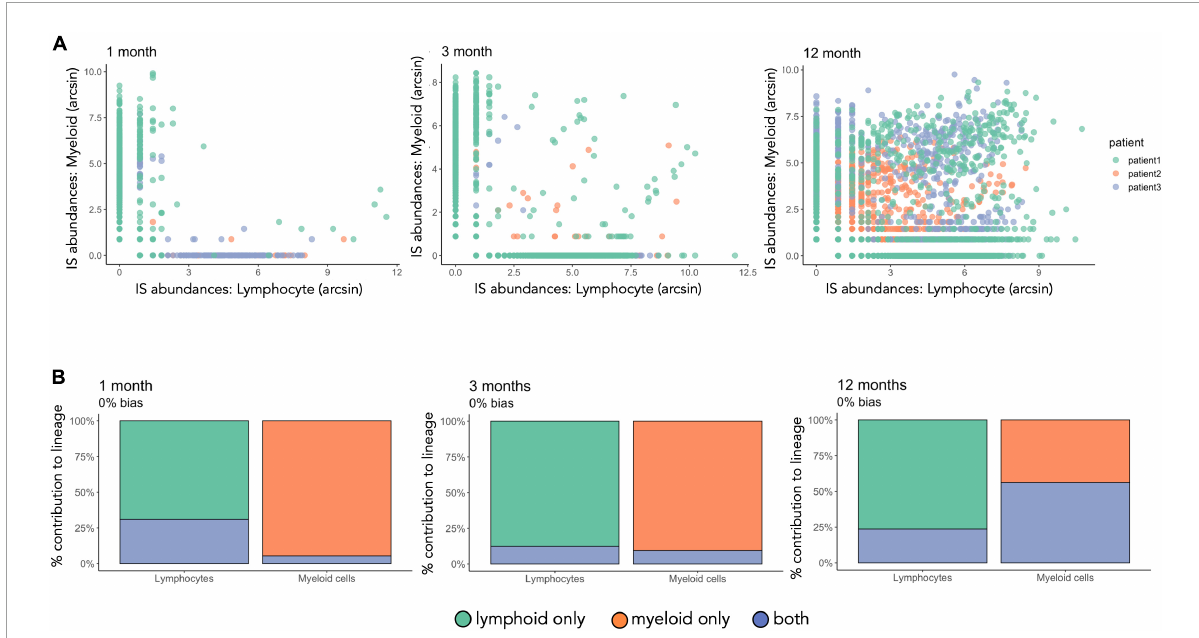
FIGURE8 Increased proportion of bi-outcome HSPC from 1 to 12 months after gene therapy. (A) IS abundances in lymphocytes versus myeloid cells for each timepoint. Each dot is an IS color-coded by patient. The number of sequencing reads per IS has been renormalized and arcsin transformed. (B) IS have been classified by presence or absence in the myeloid and lymphoid cell lineages. The total output of uni-outcome or bi-outcome HSPCs to myeloid cells and lymphocytes is computed per patient. Here we show the mean value over the three patients. Green and orange correspond to IS found only in the lymphoid or myeloid lineage, respectively (uni-outcome), blue corresponds to IS found in both lineages